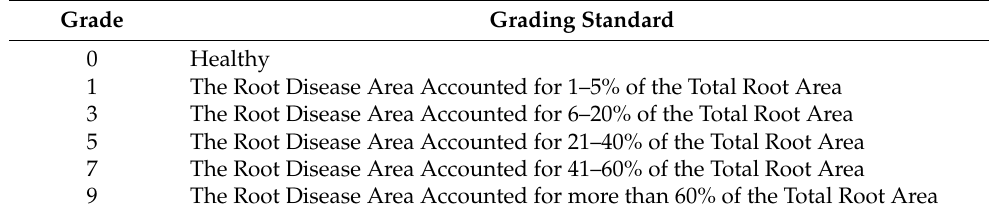
Table 1. Grading criteria for wheat